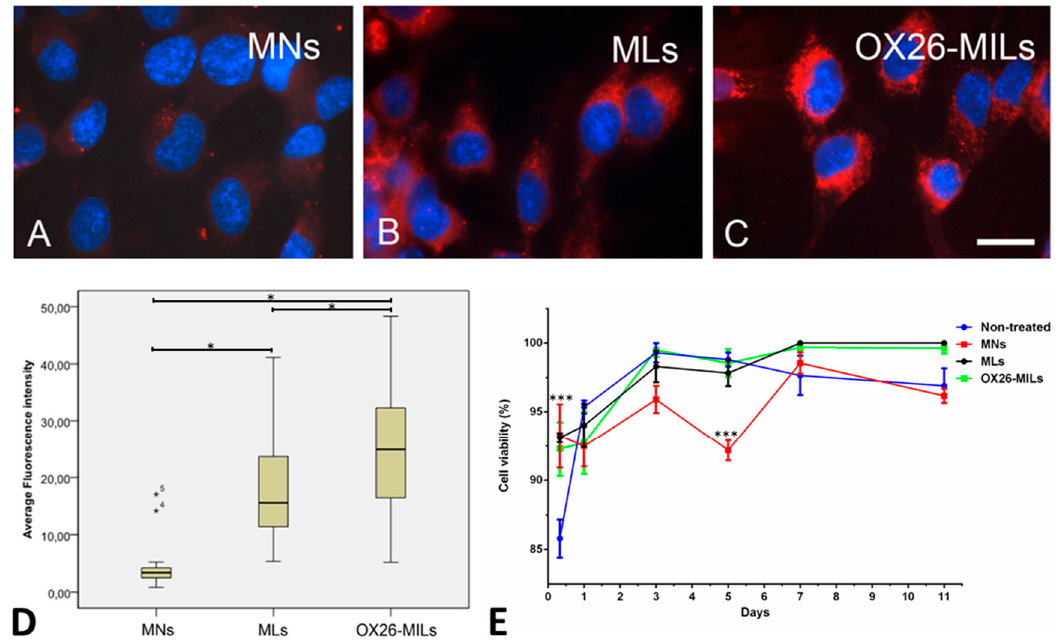
Figure 3. The uptake of red fluorescent nanoparticles in RBE4 cells, and cell viability. Cells were incubated with 1 µg of magnetic nanoparticles (MNs), magnetic liposomes (MLs), or OX26-immunomagnetic liposomes (OX26-MLs). ( A ) Uptake is virtually absent in cells incubated with magnetic nanoparticles (MNs) without a liposome coat. Magnetic liposomes (MLs) ( B ) and magnetic OX26 immunoliposomes (OX26-MLs) ( C ) exhibit prominent fluorescence inside cells, indicative of uptake. Scale bar = 10 µm. ( D ) Quantitative estimate of the fluorescence emitted by RBE4 cells after the addition of magnetic nanoparticles (MNs), magnetic liposomes (MLs), or magnetic OX26 immunoliposomes (OX26-MILs) based on computed mean fluorescence intensity of 30–50 individual measurements in each group. The three groups are all significantly different ( p ≤ 0.05), with MNs displaying the lowest intensity and OX26-MLs the highest. Outlier values are marked with asterisks numbered 4 and 5, due to their falling outside the definition as being values between 1.5 and three box lengths from the upper and lower edge of the box, respectively. ( E ) Cell viability of non-treated RBE4 cells or RBE4 cells treated for 8 h of incubation with MNs, MLs, and OX26-MILs. After 8 h, the viability of non-treated cells was significantly lower ( p ≤ 0.001) than all the treated cells. At day five, the viability of MNs was significantly lower ( p ≤ 0.001) than the non-treated cells and cells with MLs and OX26-MILs.